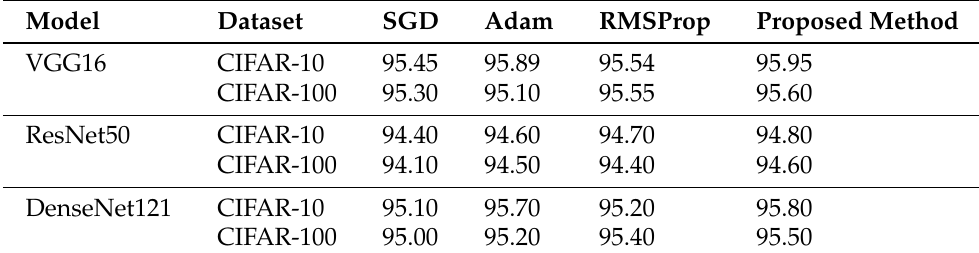
Table 5. Testing accuracy for the various machine learning models.